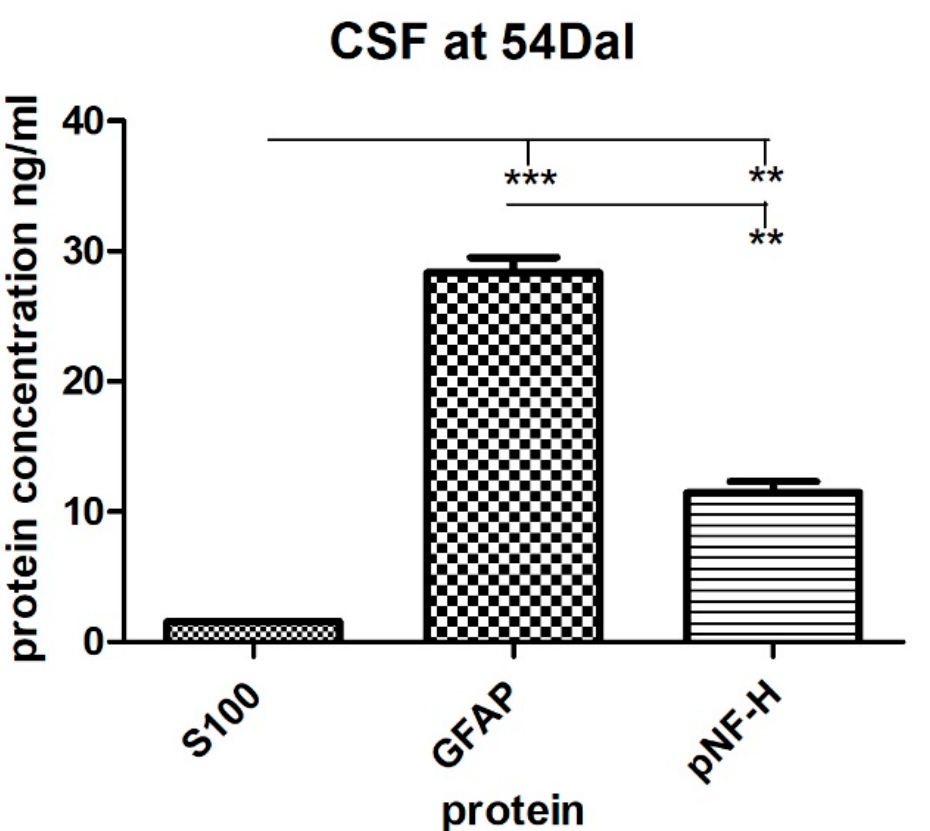
Figure 4. The levels of S100, GFAP, and pNF-H protein in the CSF of an SCI patient treated with